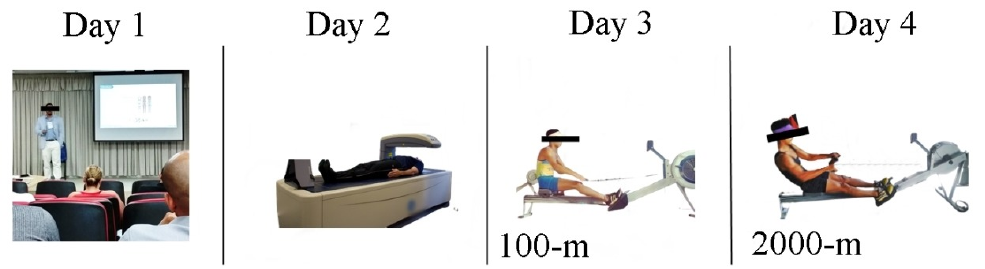
Figure 1. Study Figure 1. Study design.